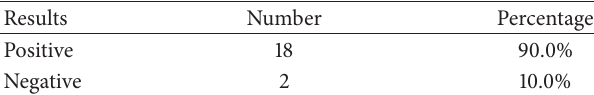
Table 4: CSF T. solium antibodies in children with neurocysticer- cosis ( 𝑁 = 20